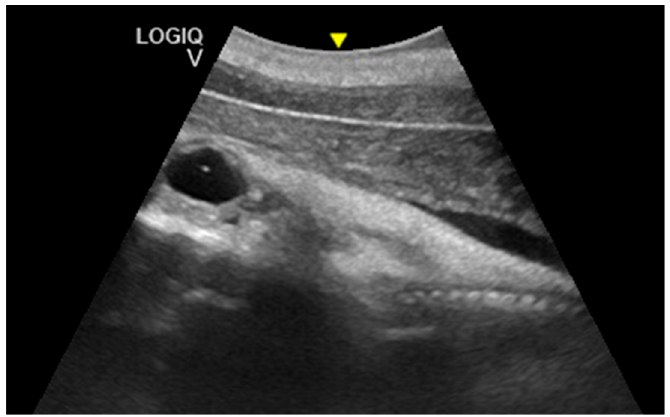
Figure 6. From day 110 ± 2 of gestation, the eye appeared as anechoic cavitary structures, whereas starting from the 149th day, the lens was also visible. At 167 ± 3 days of gestation, it was possible to identify the teeth.